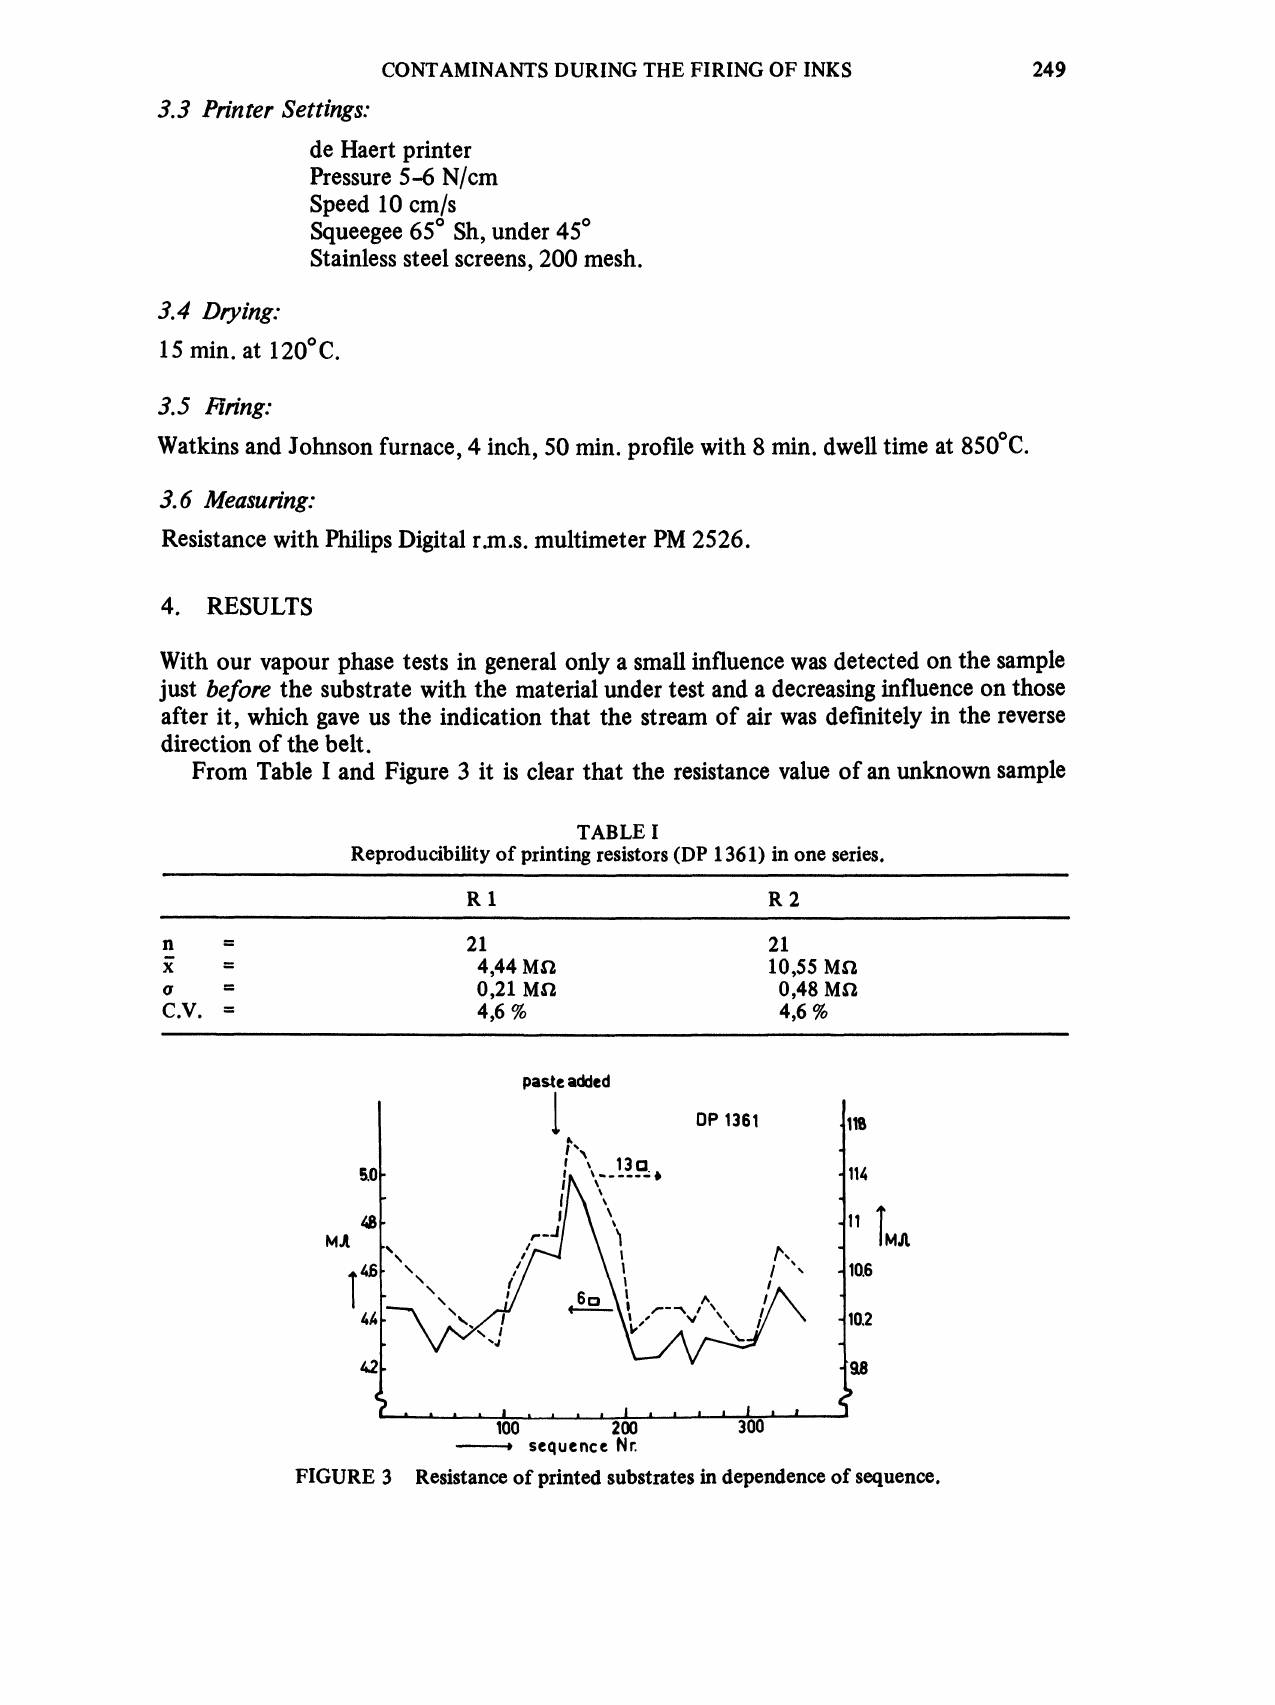
FIGURE 3 Resistance of printed substrates in dependence of